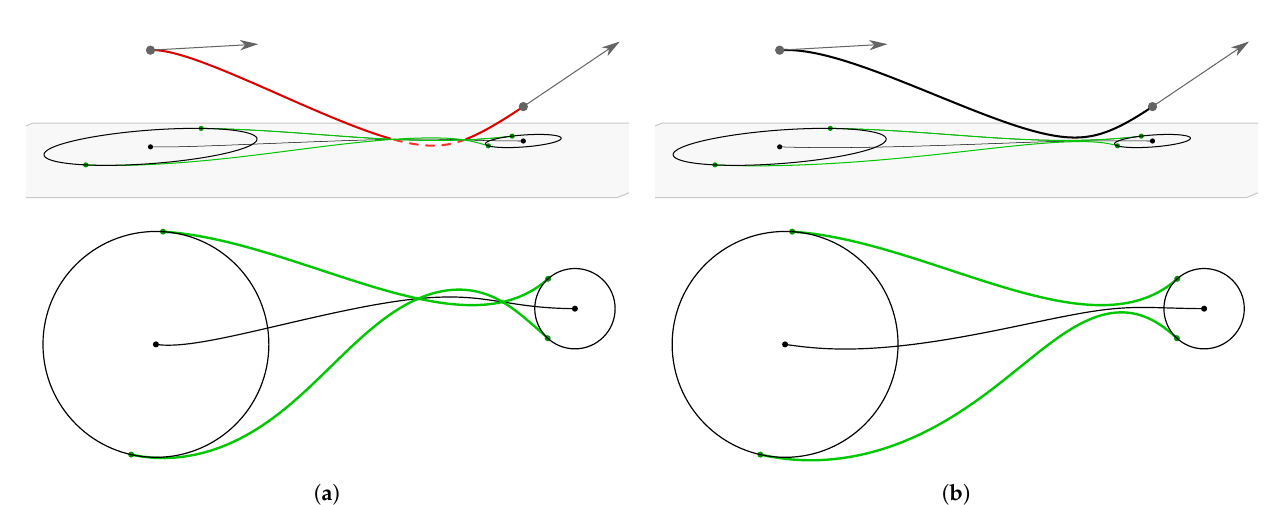
Figure 7. ( a ) The envelope curves intersect because f ( t ) has real roots in the interval [ 0,1 ] . ( b ) If we increase the order of the function, then f ( t ) can be constructed in a way that we eliminate the intersection of the envelope curves. Note that the positions of the touching points do not